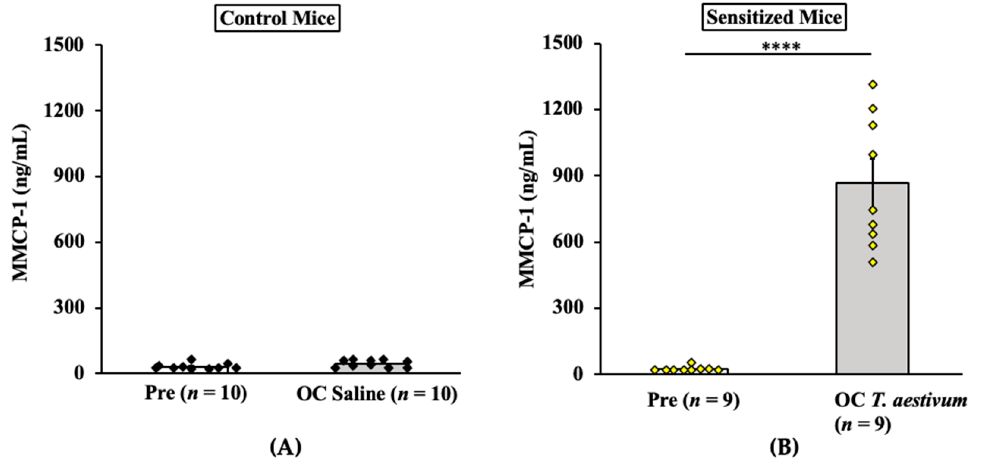
Figure 6. Oral challenge with SSPE from Triticum aestivum elicits a robust mucosal mast cell response (MMCR) in Balb/c mice. Mice were sensitized and orally challenged with T. aestivum SSPE or saline, as described in Materials and Methods. Plasma levels of mucosal mast cell protease (MMCP)-1 levels (ng/mL) in pre- and 1-h post-challenge were measured by ELISA. ( A ) MMCP-1 levels in control mice challenged with saline. ( B ) MMCP-1 levels in allergic mice challenged with T. aestivum SSPE. **** p < 0.005, student’s t -test. n : number of mice, OC: oral challenge, SSPE: salt-soluble protein extract, ELISA: enzyme-linked immunosorbent assay.